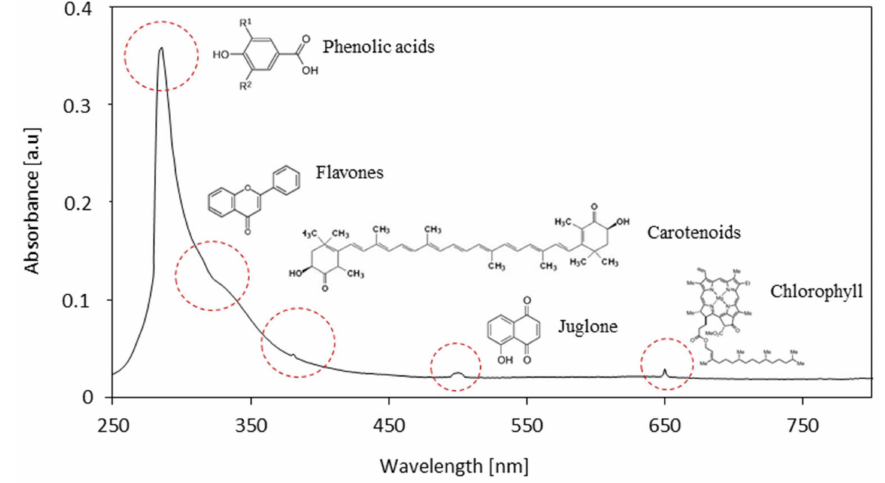
Figure 2. UV-Vis spectra of clove